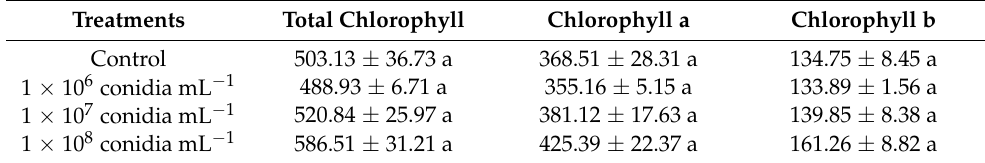
Table 9. Effects of inoculating lettuce plants with different conidial concentrations of Beauveria bassiana on total chlorophyll and chlorophyll contents a and b (Mean ± SE µ g g − 1 ) ( n =